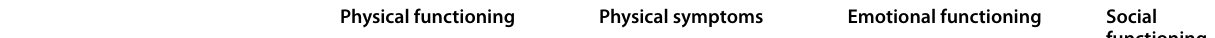
Table 3 Correlations between subscales on the Japanese version of the PedsQL Infant Scales